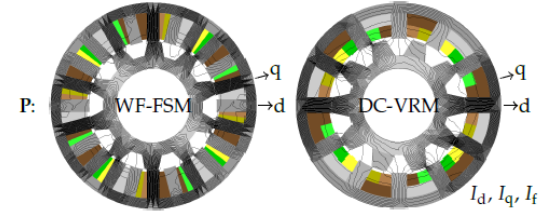
Figure 3. FEM field line solutions at rated current, current angle α = 90 ◦ and given rotor position for P : all currents non-linear FEM solution.